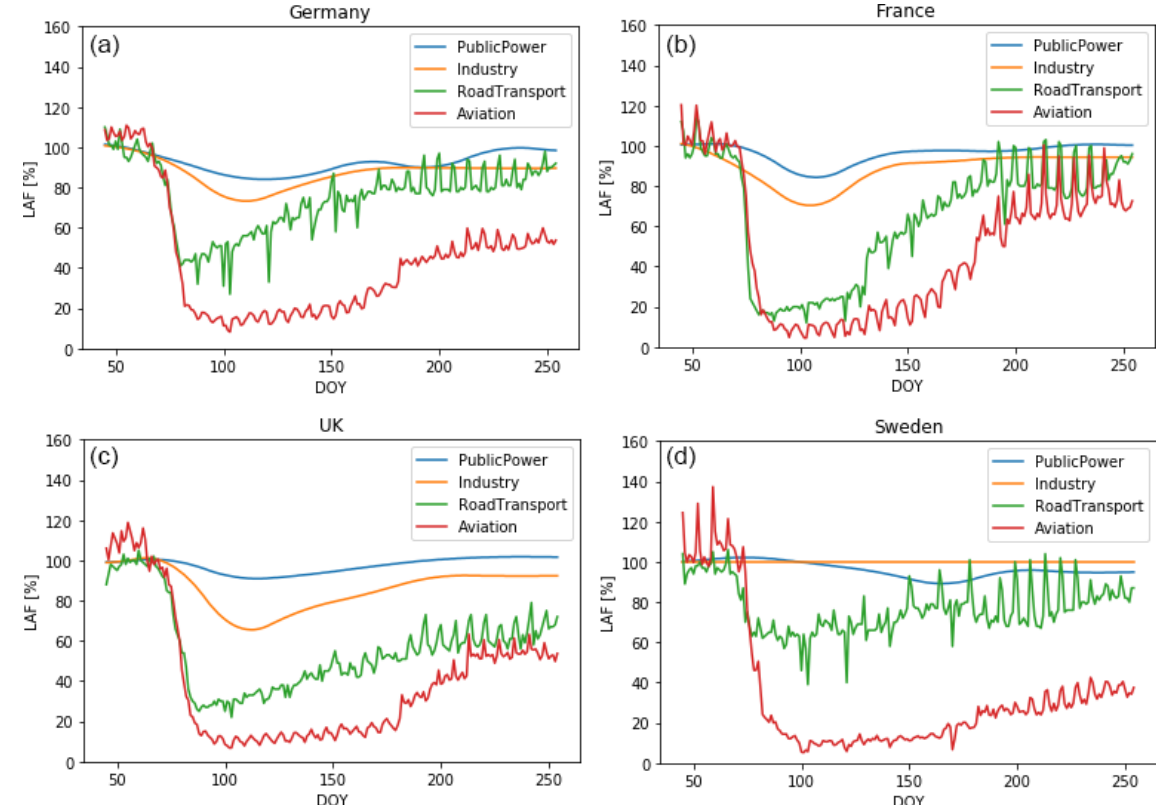
Figure 4. LAFs for Germany (a) , France (b) , the United Kingdom (c) and Sweden (d) for the sectors A_PublicPower, B_Industry, F_ RoadTransport and